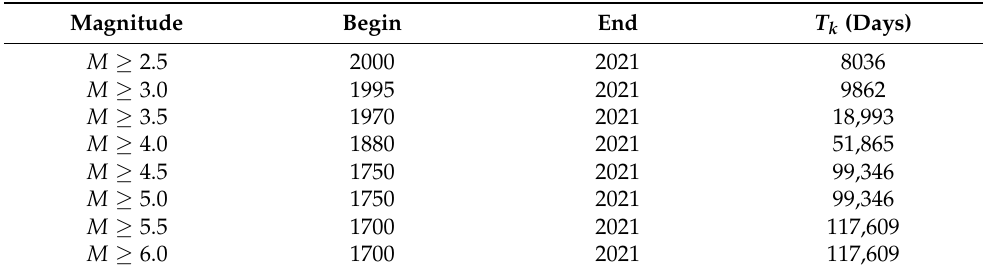
Table 3. Observation periods by magnitude